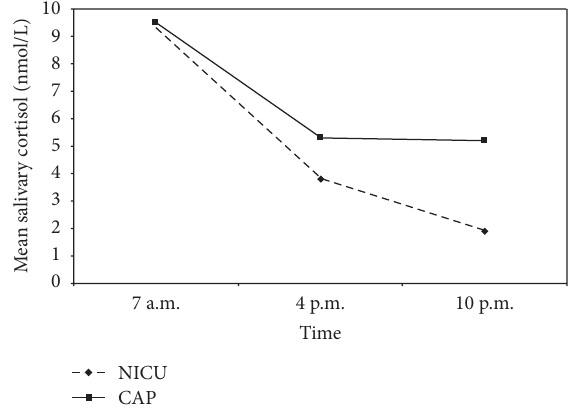
Figure 1: Mean salivary cortisol at three time points for nurses from theneonatalintensivecareunit(NICU)andthechildandadolescent psychiatry inpatient ward (CAP),